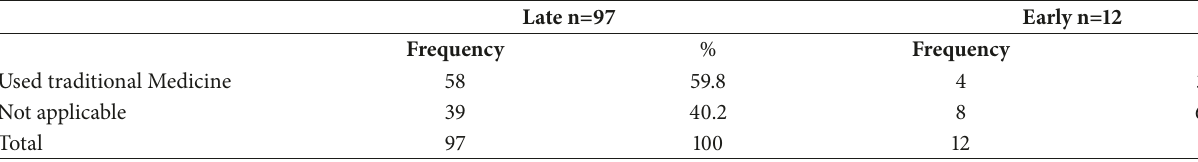
Table 4: Time and duration for patients that used traditional medicine.